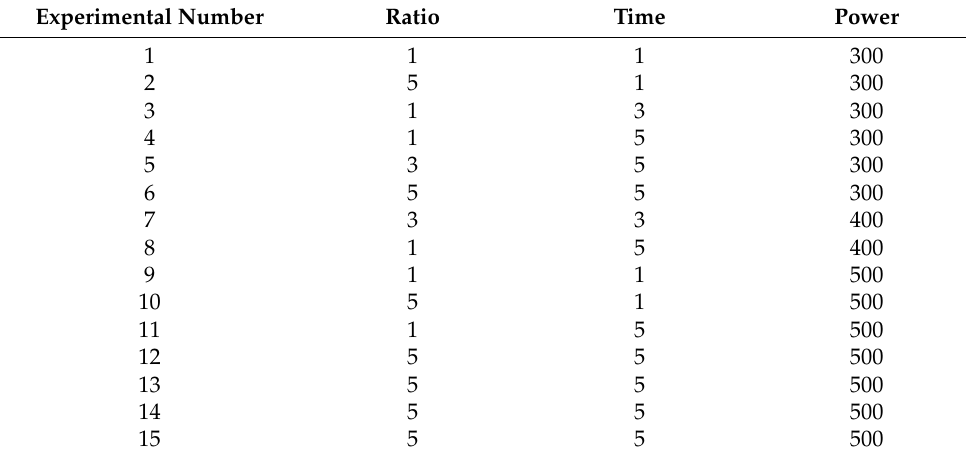
Table 2. Worksheet and responses of the experimental design. Experimental